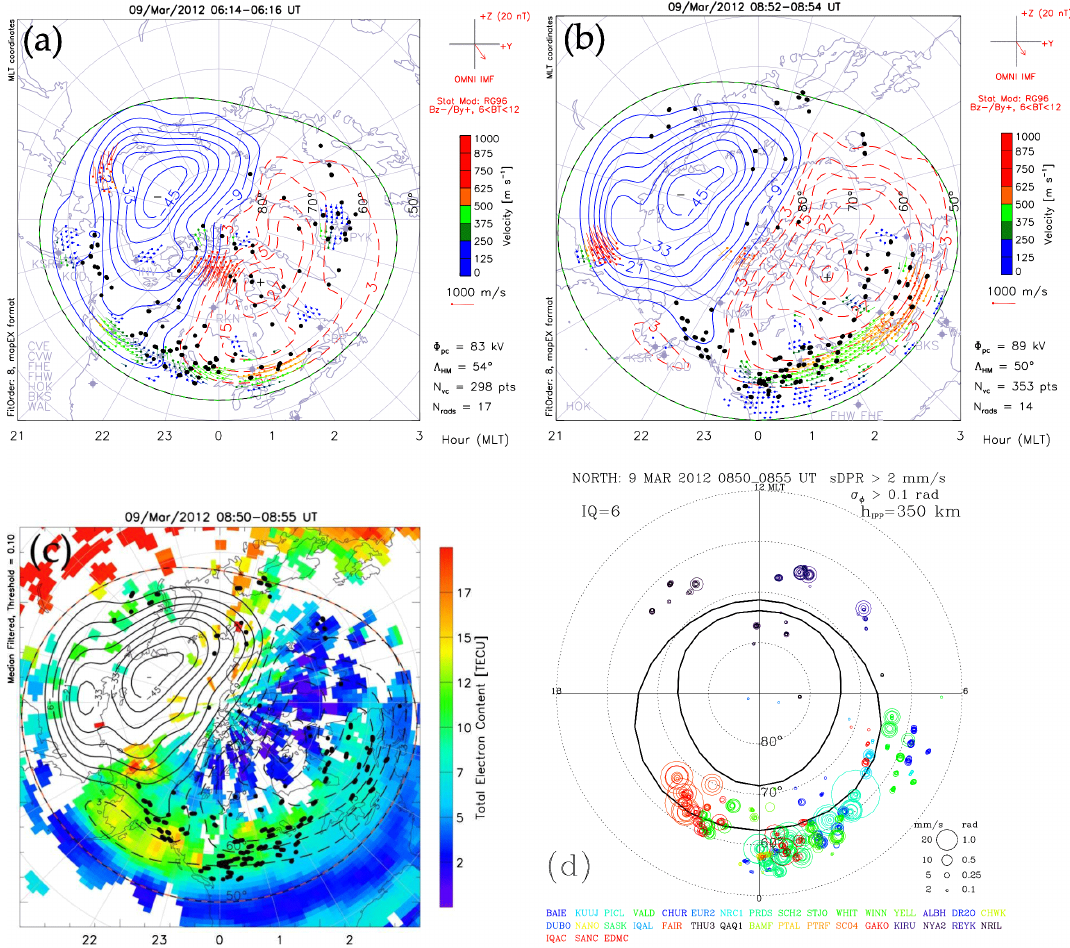
Figure 12. (a, b) Event S2: SuperDARN convection and potential maps on 9 March. The IPPs for PRNs with σ (cid:56) >0.1rad or sDPR>2mms − 1 are superposed as black dots. (c) The 5min median-filtered TEC mapped in coordinates of AACGM latitude and MLT is overlaid with the SuperDARN potential map and IPPs (black dots) for σ (cid:56) >0.1rad or sDPR>2mms − 1 . (d) The IPPs are shown as circles scaled proportionally to σ (cid:56) and sDPR